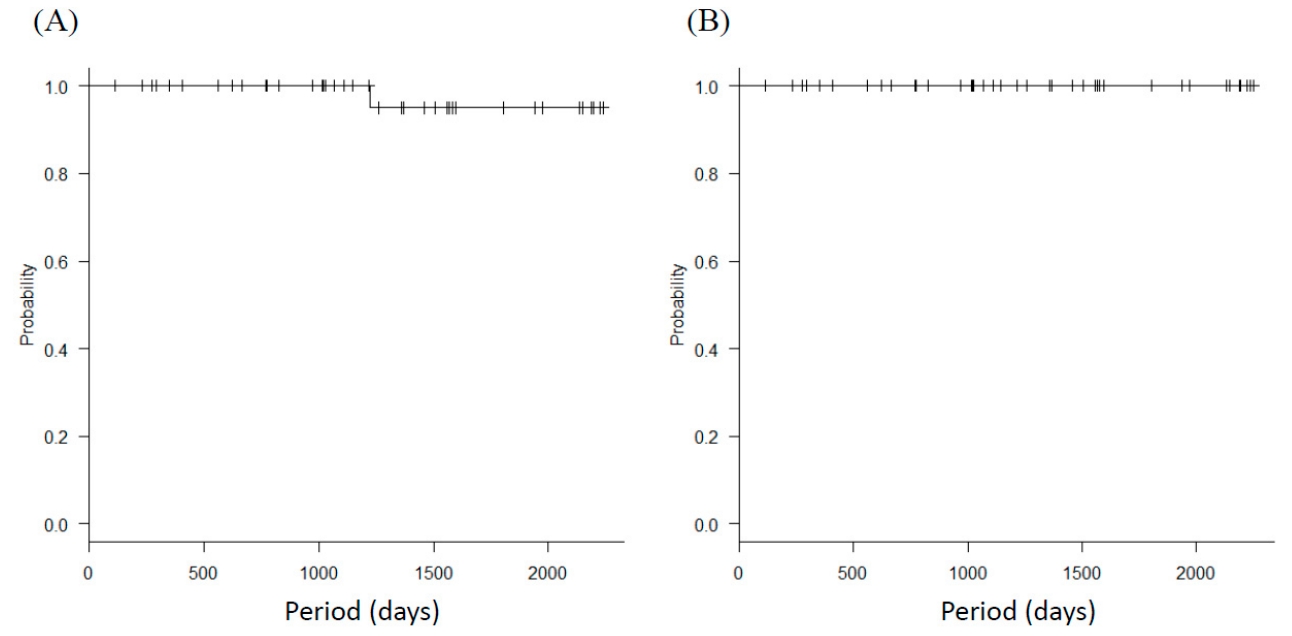
Figure 1. Survival outcomes. Kaplan-Meier analysis of ( A ) disease-free survival (DFS) and ( B ) overall survival (OS) in LRT patients.